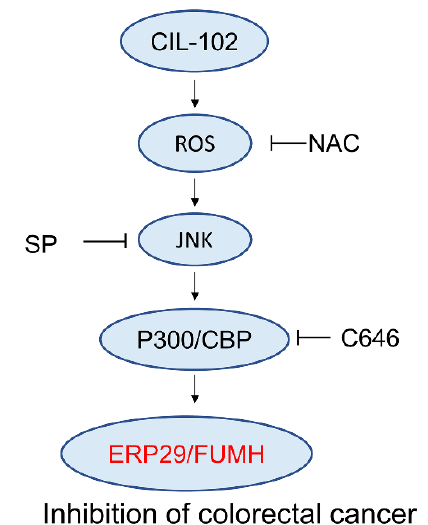
Figure 7. Working model of CIL-102 inhibits cell migration and the invasion of DLD-1 cells. ERP29 and FUMH are identified as novel CIL-102-upregulated proteins for the inhibition of cell migration and invasion in colorectal cancer. After the CIL-102 treatment, the activation of ROS and JNK/p300 CBP pathways are involved in cell migration and the invasion of colorectal cancer through the upregulation of ERP29 and FUMH.